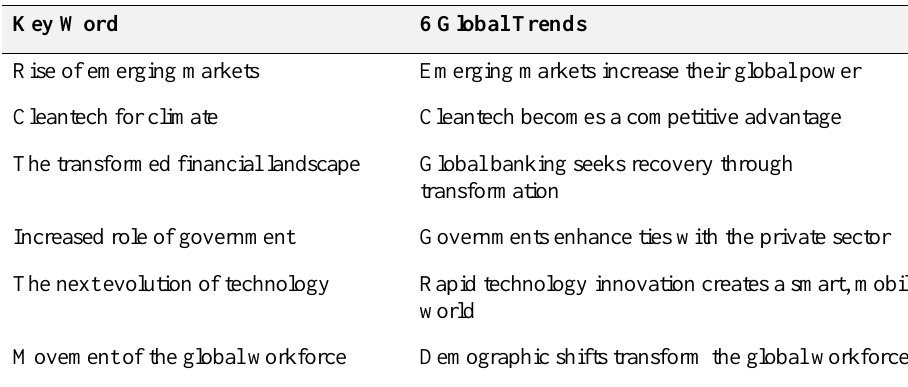
Table 2 – Key Words and Main Points of Six Global Trends Key